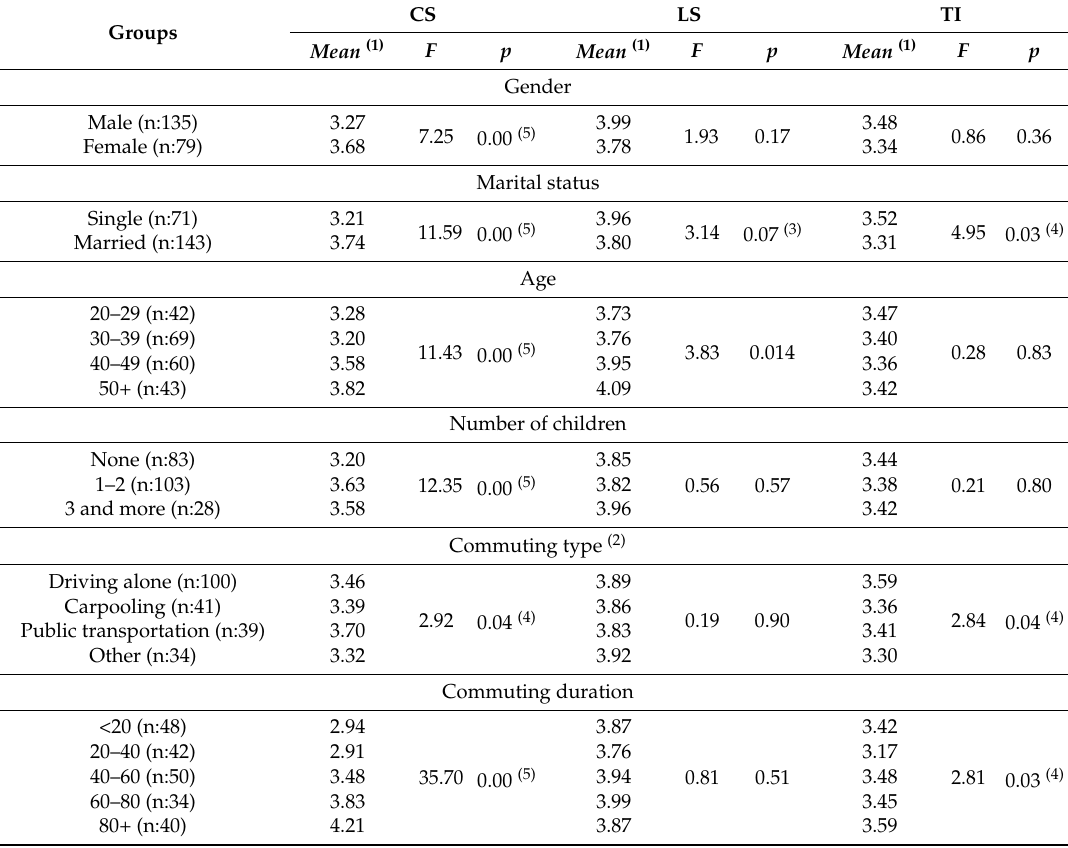
Comparison of mean differences in demographics: ANOVA F -test results ( N:214